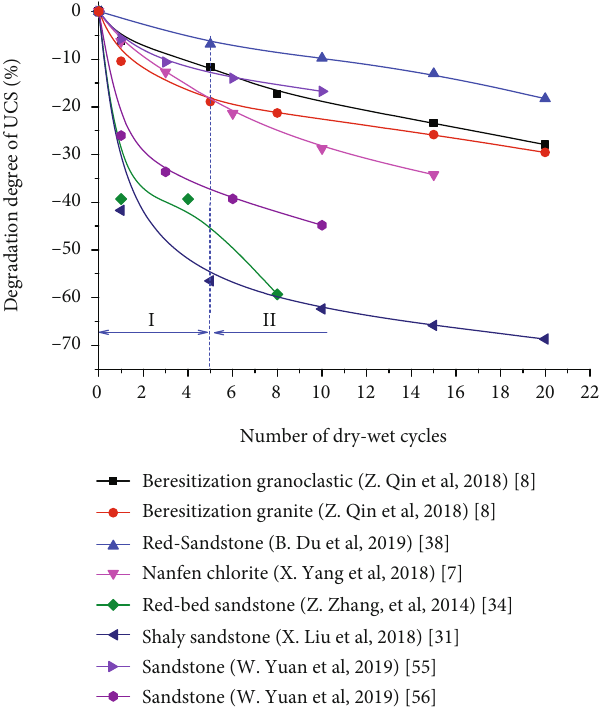
Figure 9: Degradation degree of UCS after short-term dry-wet cycles.